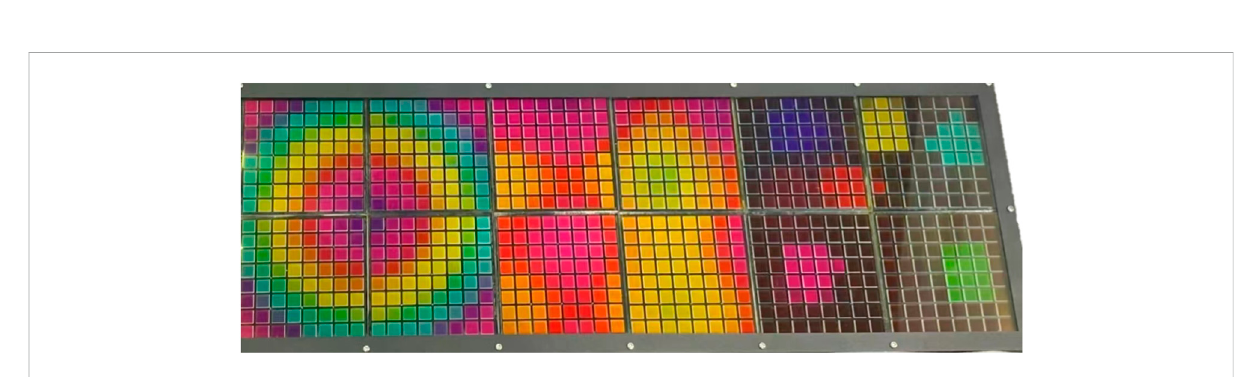
FIGURE 9 The colorful image displayed on the extended EWD is composed of a dozen display